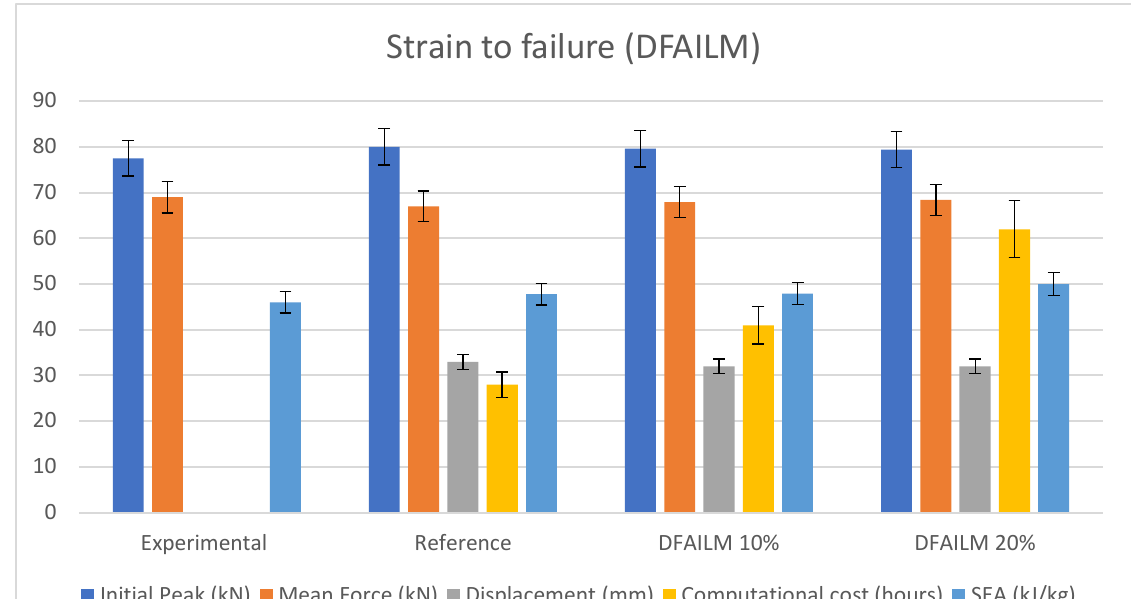
Figure 25. Strain to failure in matrix direction (DFAILM) [66].